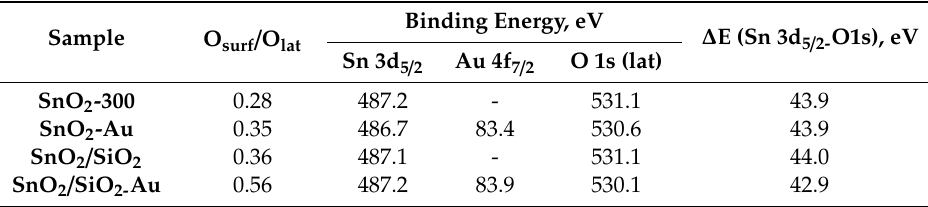
Table 4. XPS measurement results.